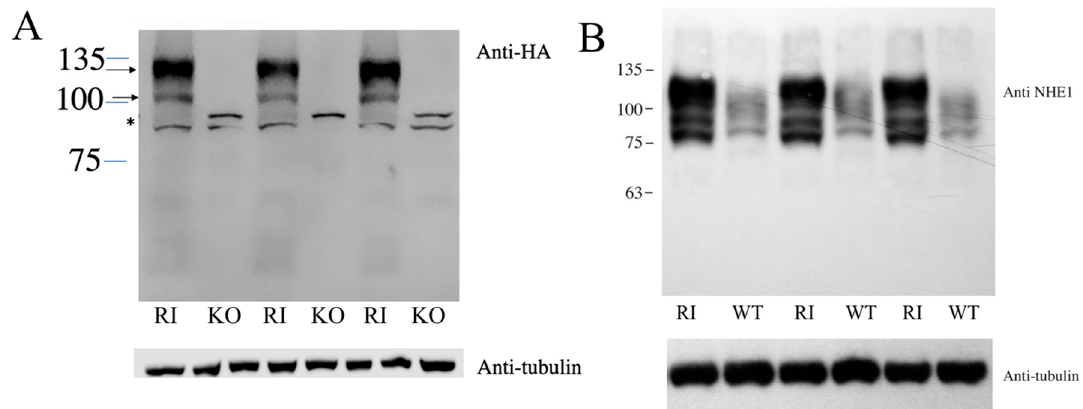
Figure 1. Western blot of DU 145 cell extracts with anti-NHE1 or anti-HA tag antibody. ( A ) Western blot of DU 145 cell extracts probed with anti-HA tag antibody. KO: DU 145 cells with NHE1 knocked out; RI: KO cells with HA-tagged NHE1 returned. Arrows indicate NHE1, * indicates non-specific band. Lower panel probing with anti-tubulin antibodies. ( B ), Western blot of DU 145 cell extracts probed with anti-NHE antibody. WT: wild-type DU 145 cells; RI: KO cells with HA-tagged NHE1 returned. Probed with anti-NHE1 antibodies. Lower panel probing with anti-tubulin antibodies.